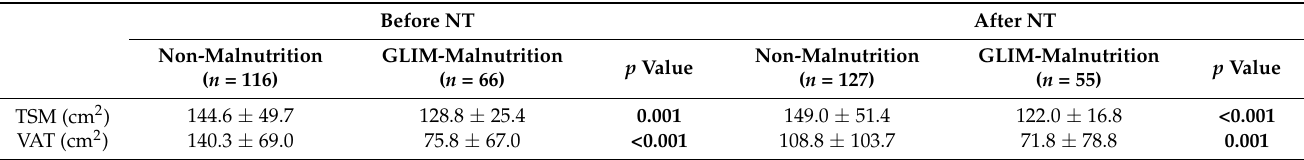
Table 2. Association between body composition and GLIM-defined malnutrition.